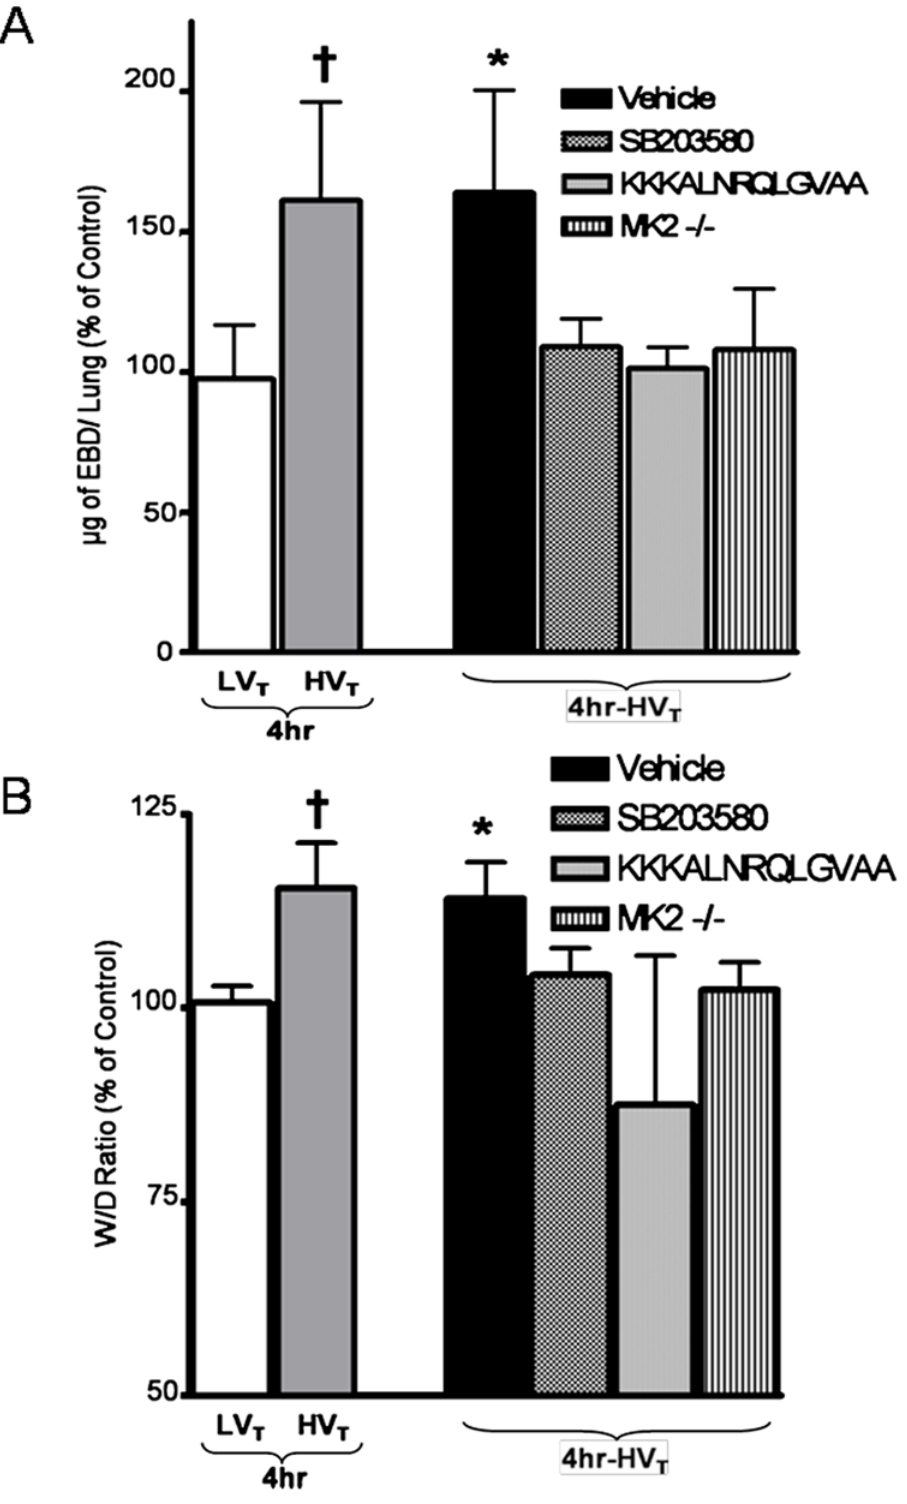
Figure 5. Inhibition of the p38 MAP kinase-MK2-HSP25 pathway prevents pulmonary capillary permeability in response to high tidal volume mechanical ventilation. Wild type and MK2 2 / 2 mice were randomized to spontaneous breathing (Control) or HV T MV for 4 hours, and EBD extravasation and wet-to-dry lung weight ratios were assessed. A subset of wild type mice were pretreated with vehicle (DMSO), the p38 MAP kinase inhibitor SB203580 or the MK2 inhibitor KKKALNRQLGVAA. A. The amount of EBD extravasation after MV at HV T was significantly higher in mice treated with vehicle compared to mice treated with SB203580, KKKALNRQLGVAA or untreated MK2 2 / 2 mice (1.64 6 0.35 Vs. 1.08 6 0.1, 1.01 6 0.07 and 1.06 6 0.21 respectively), EBD extravasation after MV at LV T and HV T for 4 hr without treatment is also shown for comparison. B. The wet-to-dry lung weight ratio after MV at HV T was significantly higher in mice treated with vehicle compared to treatment with SB203580,